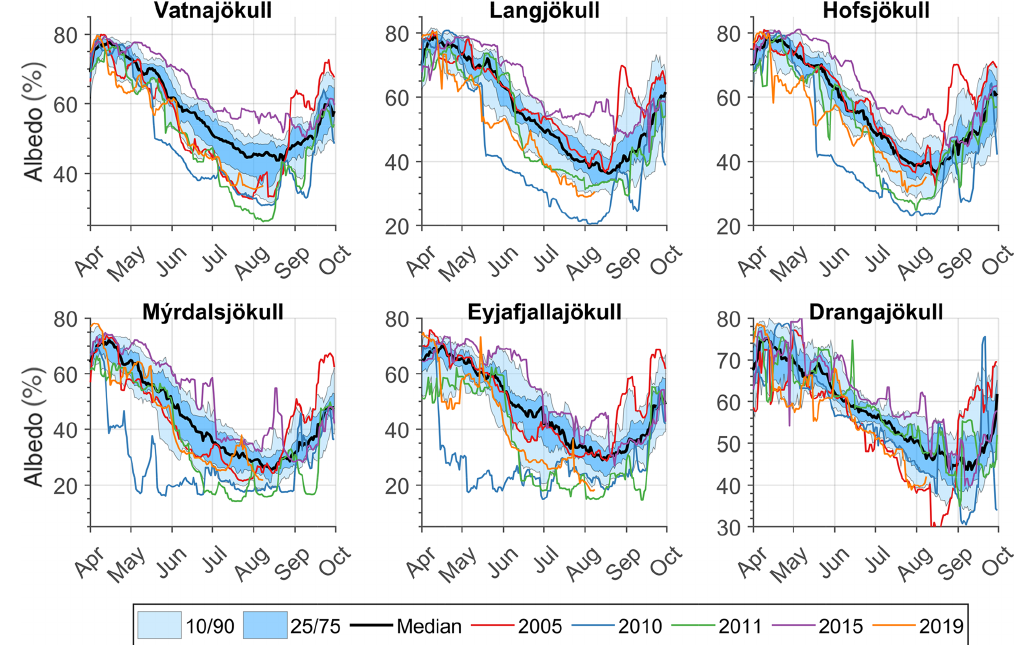
Figure 8. Seasonal variations in average albedo for selected Icelandic glaciers from the MCD11 product for April to October 2000–2019.